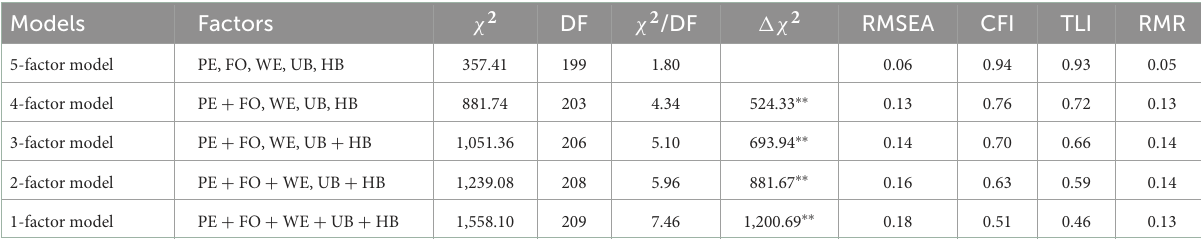
TABLE 1 Results of confirmatory factor analysis.